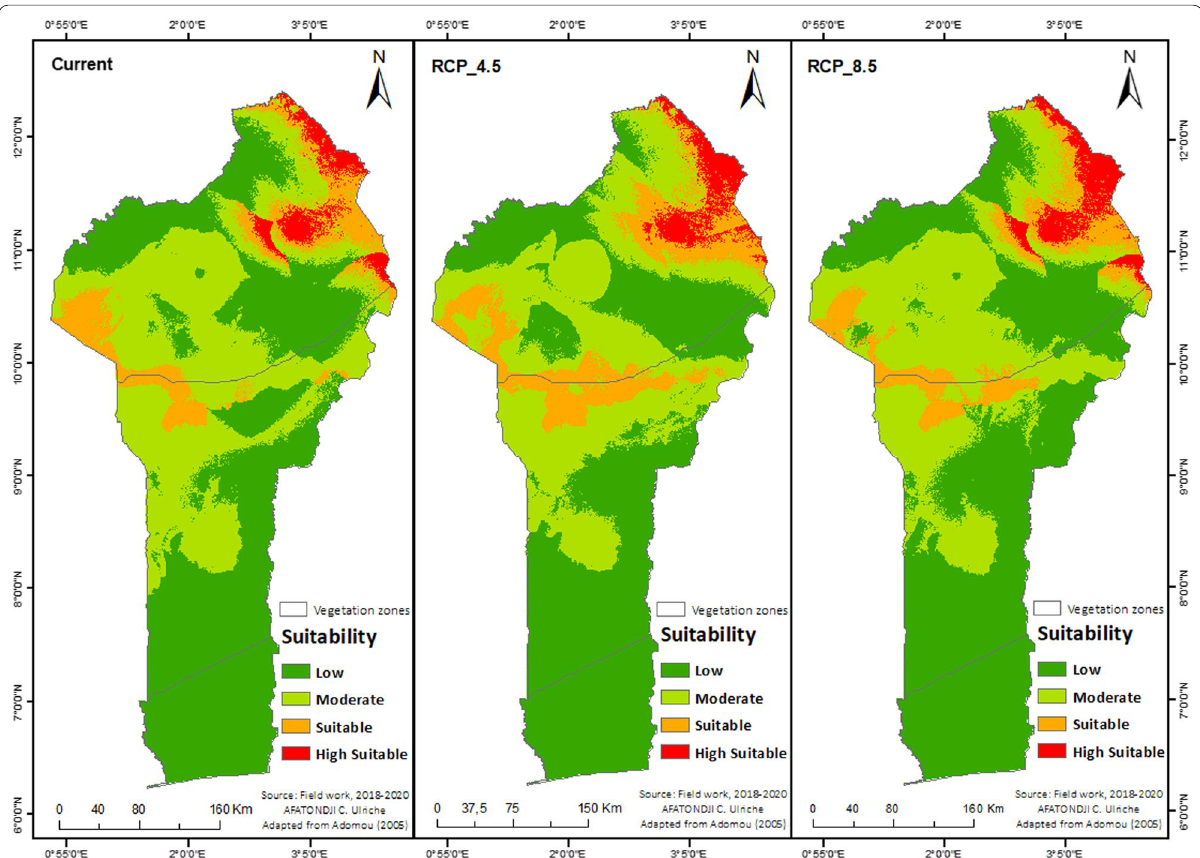
Fig. 9 Map of current and future potential suitable habitats for Goat Type II under RCP 4.5 and RCP 8.5 across Benin. RCPs 4.5 and 8.5 are climate scenarios of 4.5 W m − 2 and 8.5 W m − 2 ,